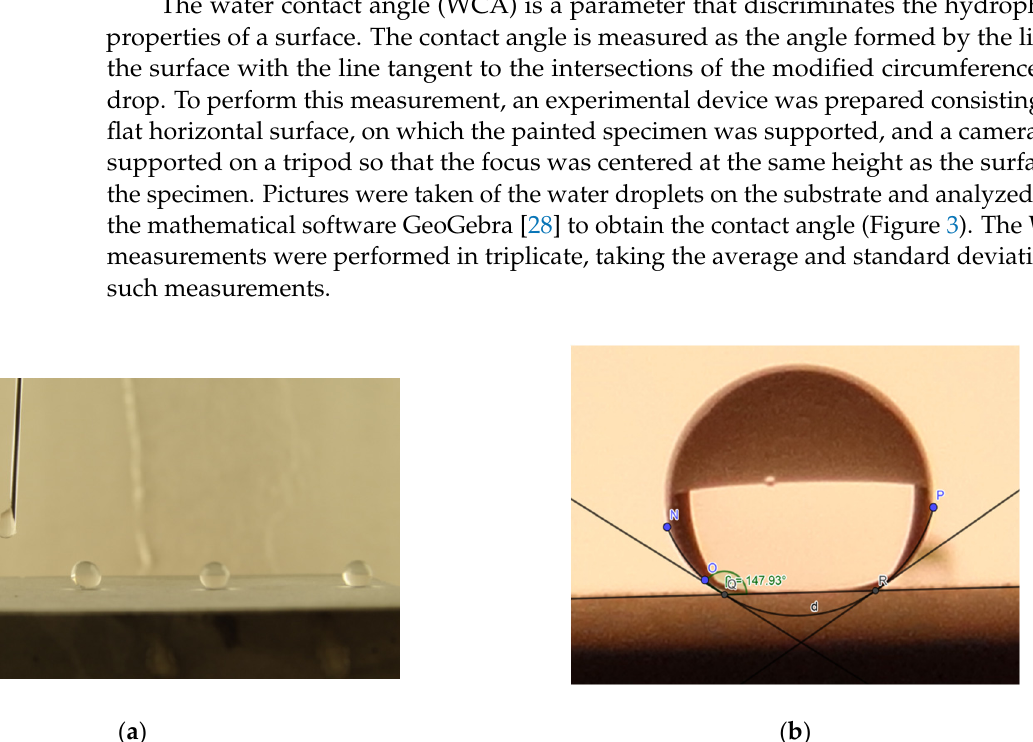
Figure 2. Scheme of the sample preparation process.